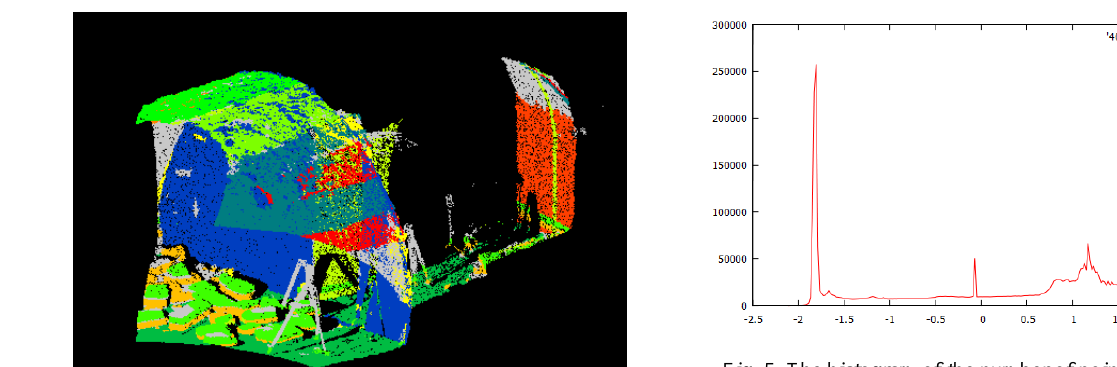
Fig. 5. The histogram of the number of points as the Z co- ordinate function